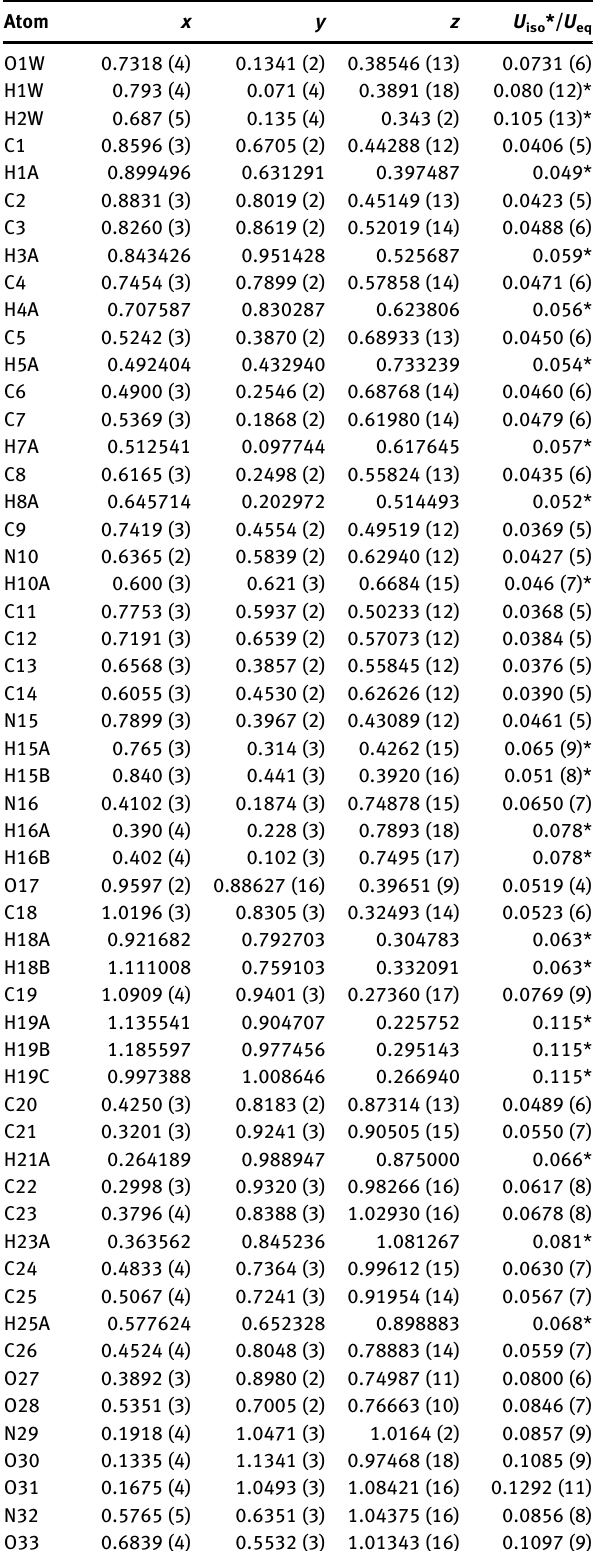
Table  : Fractional atomic coordinates and isotropic or equivalent isotropic displacement parameters (Å 